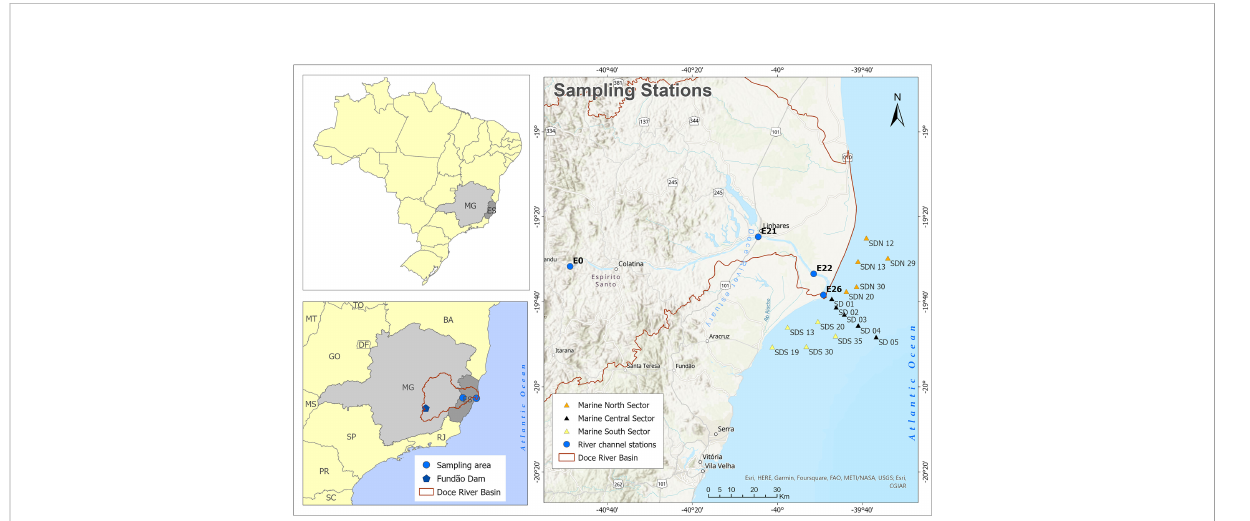
FIGURE 1 Study area on the southeast coast of Brazil. Light grey is the Minas Gerais State, where the Fundão iron ore tailing dam collapsed (blue star); Dark grey is the Esp ı ́ rito Santo State, where the coastal sampling area is located. Doce River watershed boundary is delimited by the brown line. The blue dots are the sampling area and sampling stations in the Doce River channel; the orange triangles are the marine north sector (MN), the black triangles are the marine central sector (MC) and the yellow triangles are the marine south sector